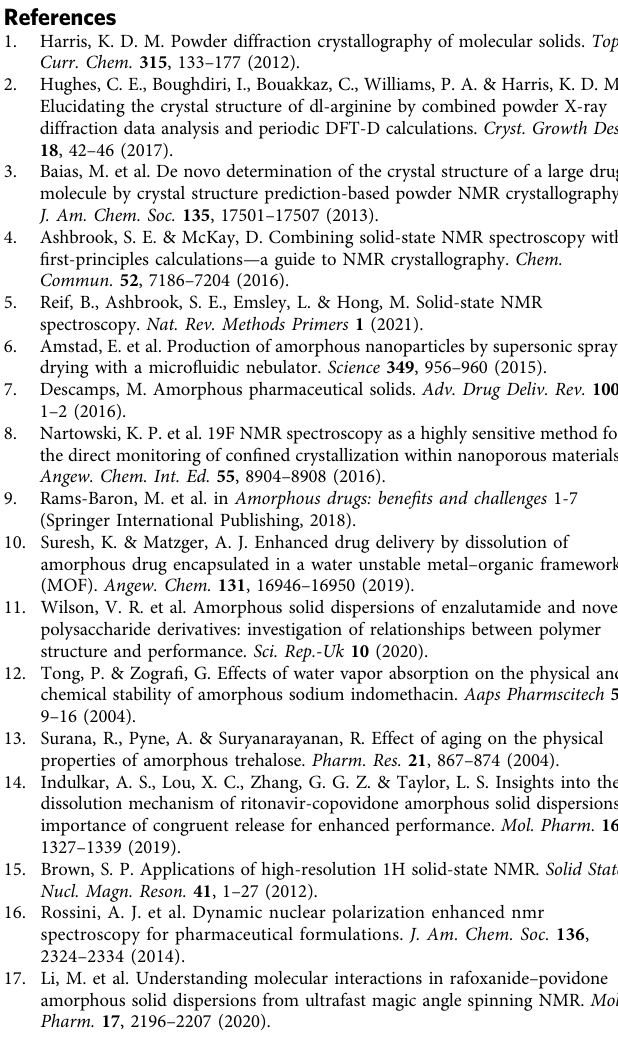
H-bonded neighbour was found to be a water molecule, then secondary water- bound neighbours were searched for using the same criteria to de fi ne hydrogen bonds.